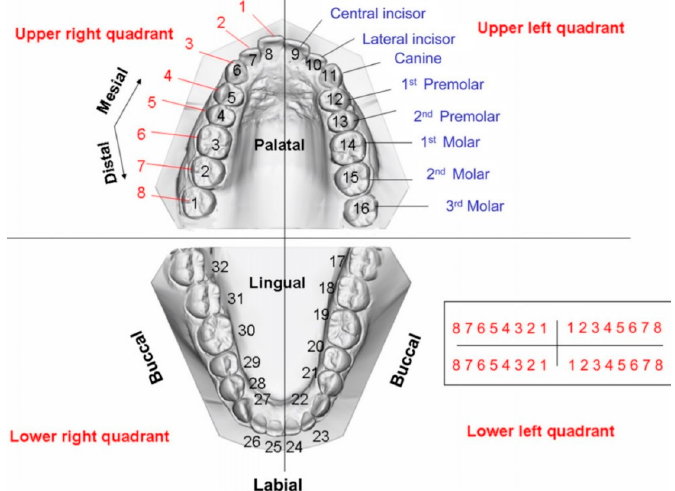
Figure 2. Maxillary and mandibular dental arches. The individual teeth can be numbered sequentially from mesial to distal in each quadrant (indicated in red) or uniquely numbered, starting with the right maxillary third molar as tooth number 1 (shown in black). The orientation of the teeth is indicated by labial, buccal, lingual, and palatal as reference. The relationship between teeth is indicated by mesial-distal terms [26]. Published by Elsevier.